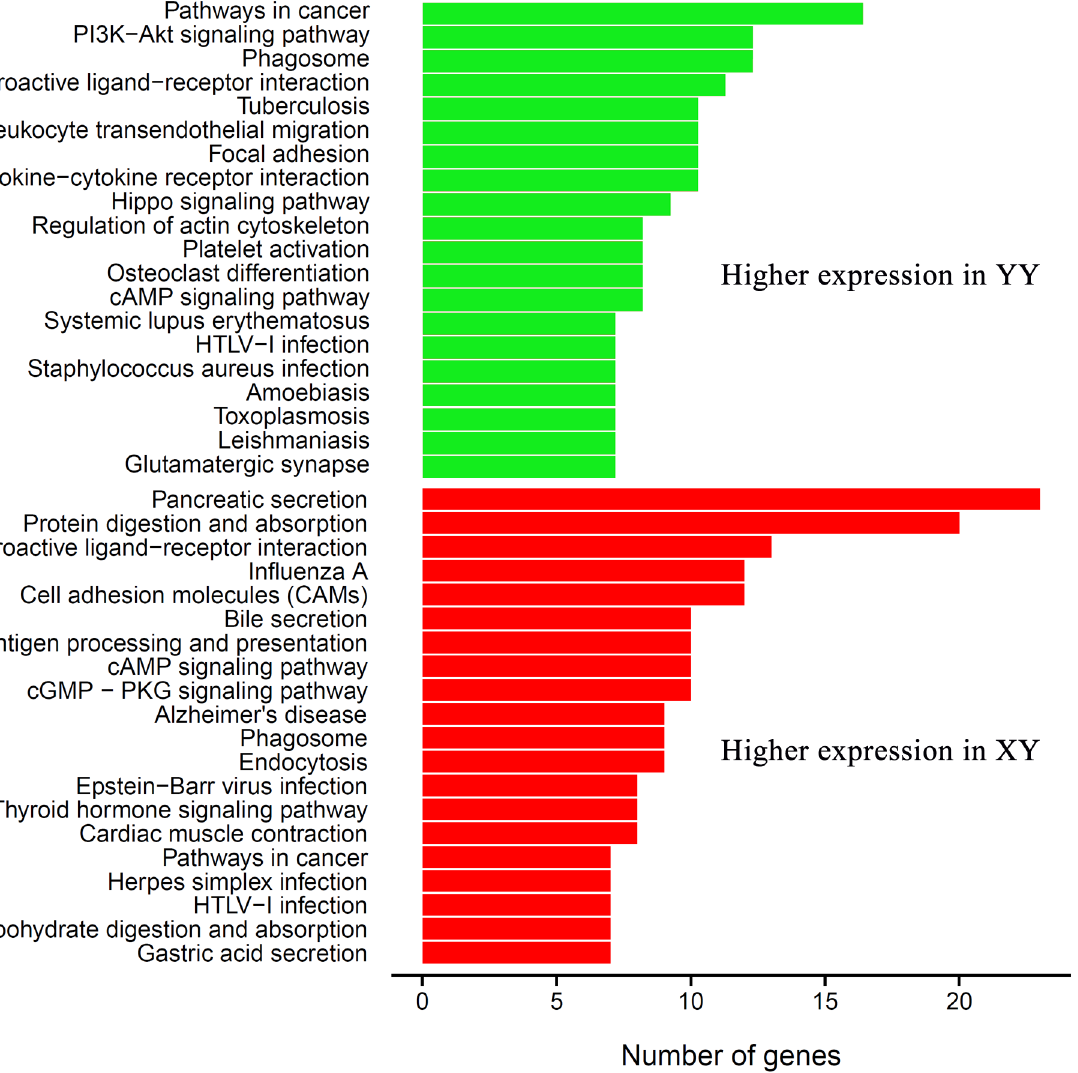
Fig 4. KEGG classification of the DEGs between transcriptomes of YY and XY testis. The green and red columns represent the signaling pathways enriched in YY and XY testes, respectively. doi:10.1371/journal.pone.0134626.g004 PLOS ONE | DOI:10.1371/journal.pone.0134626 August 4,